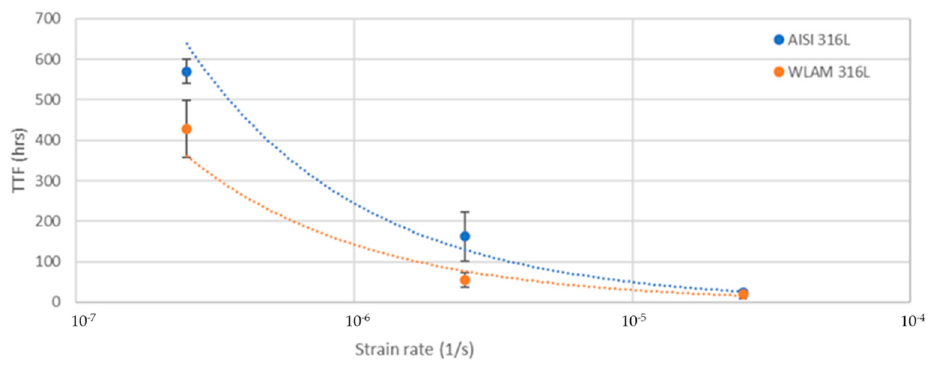
Figure 10. Time to failure vs. strain rate of the WLAM samples and the counterpart AISI 316L alloy.